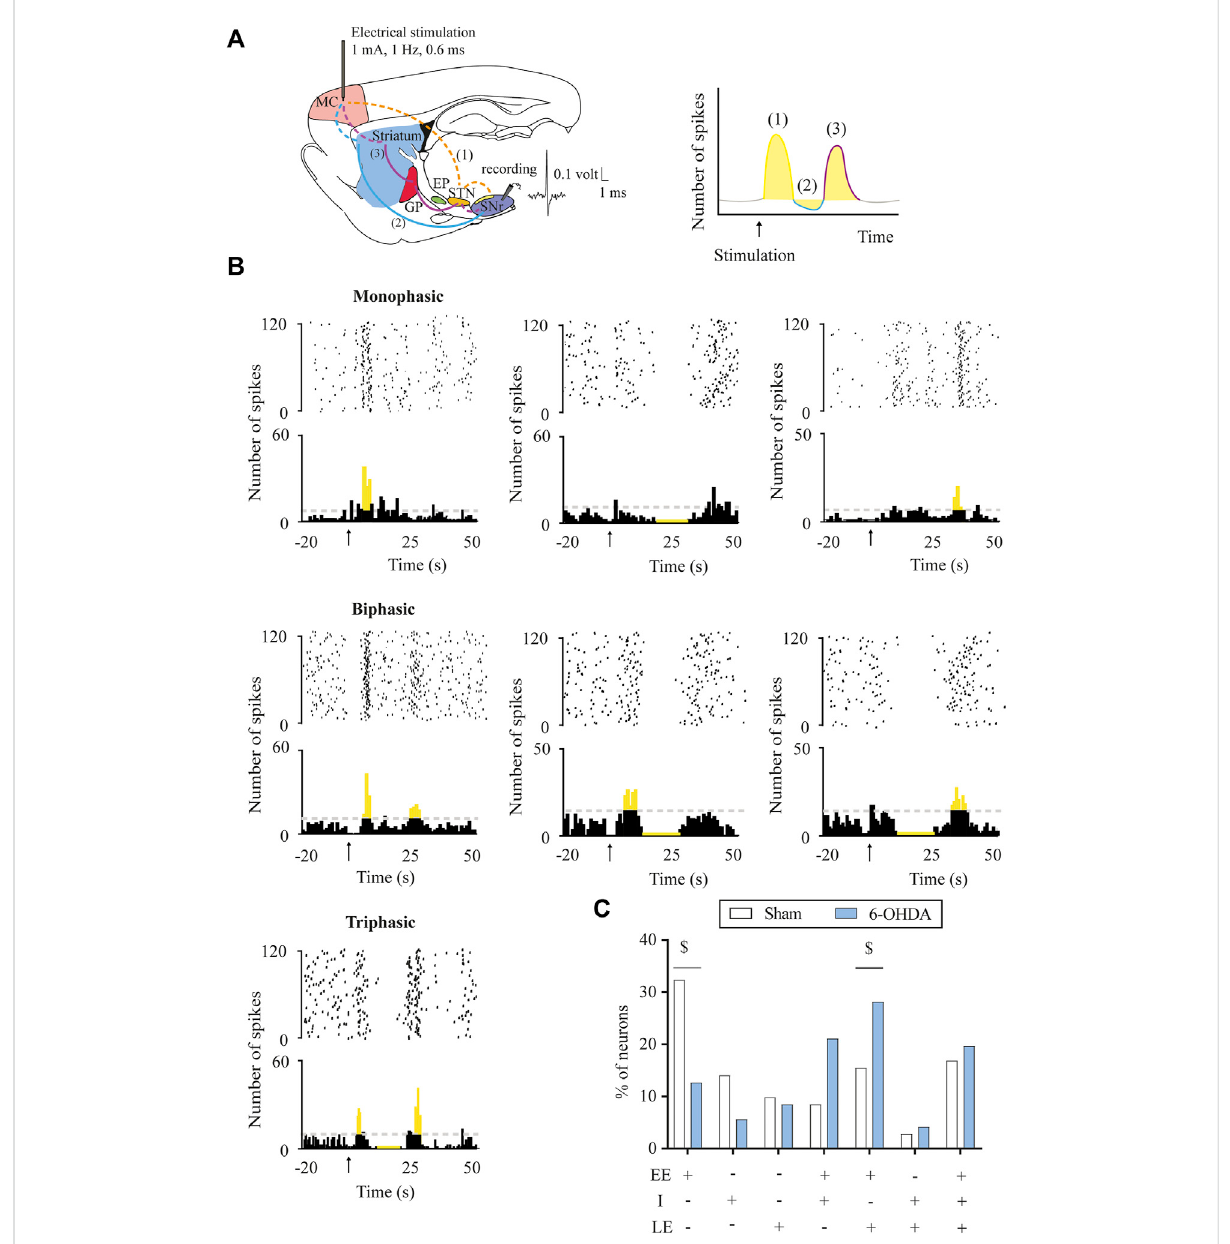
FIGURE 1 Response patterns evoked in substantia nigra pars reticulata neurons by motor cortex stimulation. (A) Left, schematic parasagittal rat brain section illustrating the motor cortex (MC) projections to the BG nuclei (striatum, GPe, STN, and SNr) responsible for each response pattern. Dashed lines represent glutamatergic projections and solid lines, GABAergic projections. On the right, raster plot and peristimulus time histogram showing the characteristic cortically evoked triphasic response in SNr neurons: 1) early excitation (EE) in yellow: activation of hyperdirect pathway (cortex-STN-SNr), 2) inhibition (I) in blue: activation of direct pathway (cortex-striatum-SNr), and 3) late excitation (LE) in red: activation of indirect pathway (cortex-striatum-GPe-STN-SNr). (B) Raster plot and peristimulus time histogram showing the different representative examples of a monophasic, biphasic, and triphasic response evoked in a SNr neuron. (C) DA loss-induced changes in the percentage of SNr neurons displaying different patterns of response: the proportion of neurons displaying monophasic (i.e., early excitation) responses was reduced, in favour of more biphasic(i.e.,earlyexcitation+lateexcitation)responsesinthe6-OHDA-lesionedgroup.Dataareexpressedaspercentages. $ p < 0.05(Fisher ’ sexact